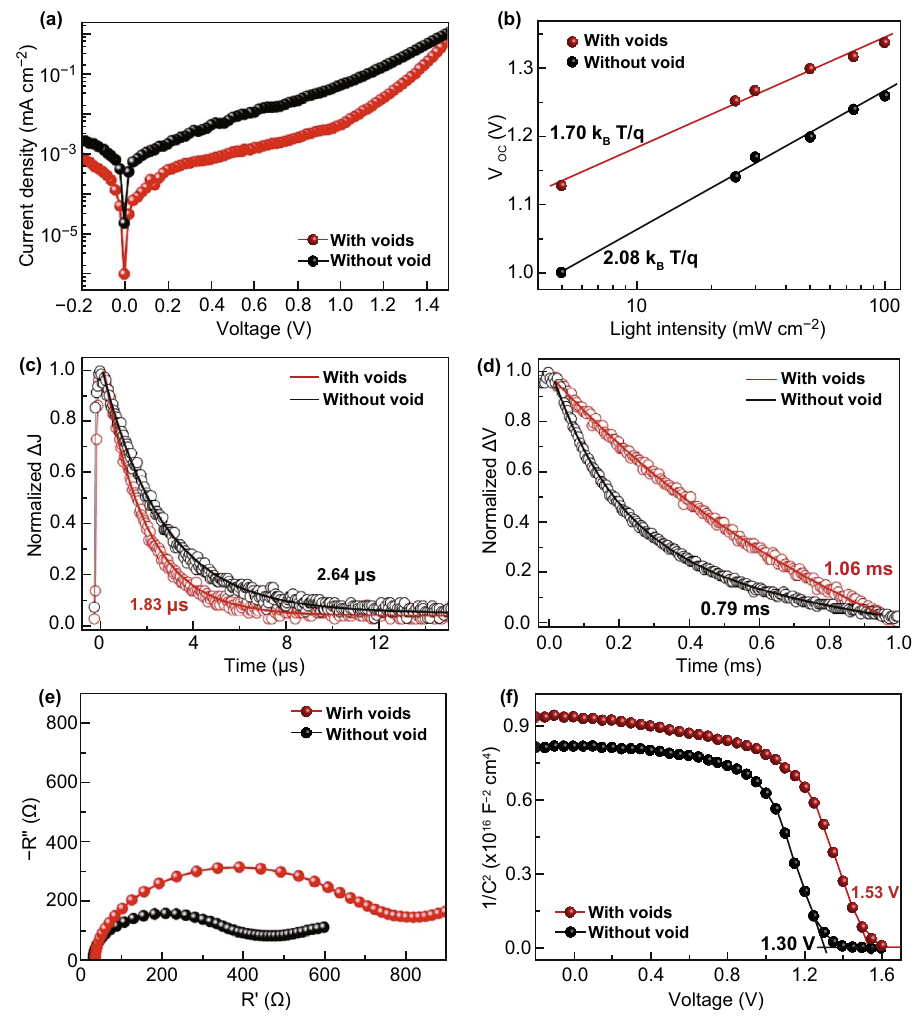
Fig. 5 a Dark J – V curves, b the dependence of V oc on light intensity, c TPC curves, and d TPV curves for the PSCs based on CsPbIBr 2 films without and with interfacial voids, e Nyquist plots and f M–S plots of the same